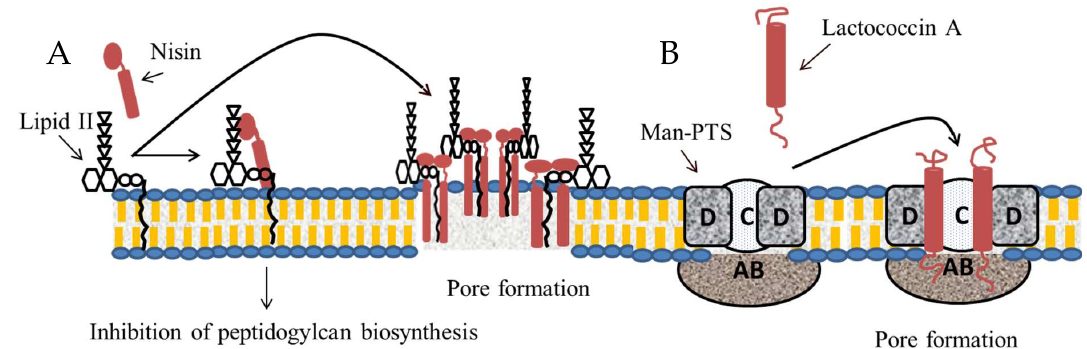
Figure 4. Mechanisms of action of nisin and lactococcin A. ( A ) By targeting lipid II, nisin can inhibit peptidoglycan biosynthesis and form pores in the bacterial membrane. ( B ) Lactococcin A uses the mannose phosphotransferase system (Man-PTS) as a receptor, leading to uncontrolled opening of this receptor and thereby forming a pore in the bacterial membrane.